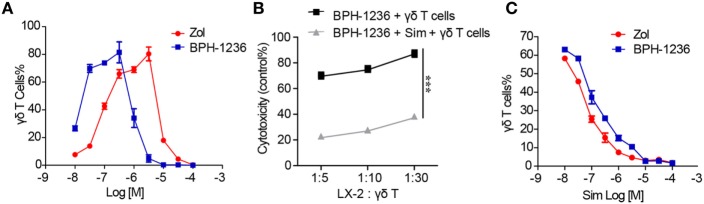
BPH-1236 performs better and functions via inhibiting farnesyl diphosphate synthase (FPPS). (A) Response of human blood Vγ9Vδ2 T cells to zoledronate or BPH-1236 treatment. Isolated human peripheral blood mononuclear cells (PBMCs) were treated with zoledronate or BPH-1236 for 3 days, and cells were allowed to proliferate for another 9 days, followed by staining for CD3 and TCR Vδ2. (B) The rescue effect of simvastatin on the cytotoxicity of Vγ9Vδ2T cells against LX-2 cells that were pretreated with BPH-1236. ***P < 0.001. (C) The rescue effect of simvastatin on the response of human blood Vγ9Vδ2 T cells to zoledronate or BPH-1236. All data are presented as mean ± SEM of three replicates from a representative experiment of three independent experiments.